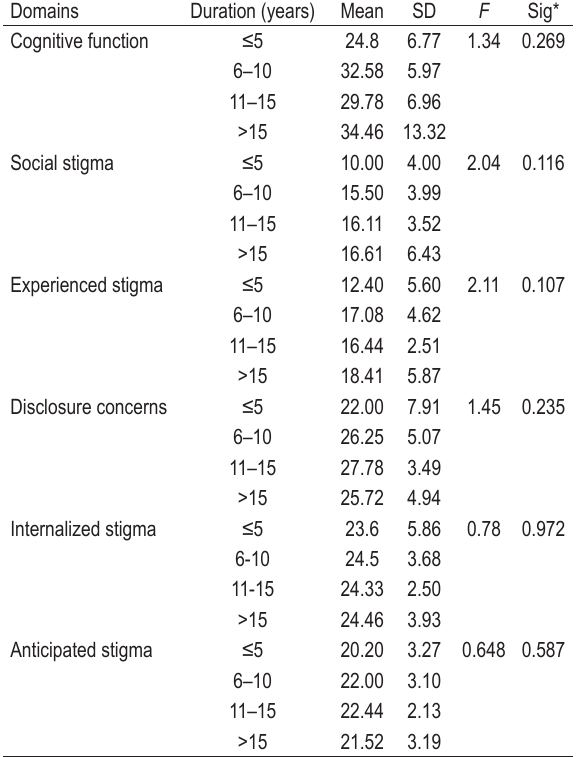
TABLE 7. Comparison of stigma mean scores between the duration of lymphoedema in six different domains